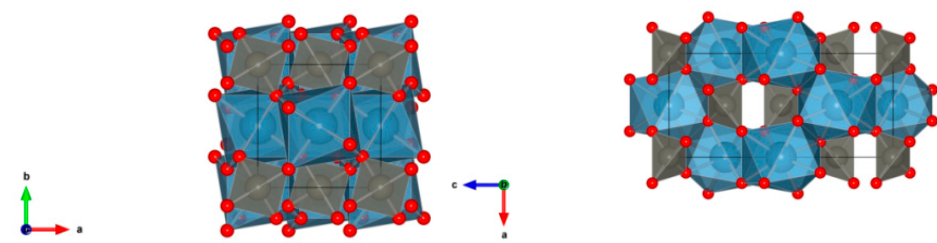
Figure 4. Diagram of scheelite structure [25] (drawn by VESTA [26]).